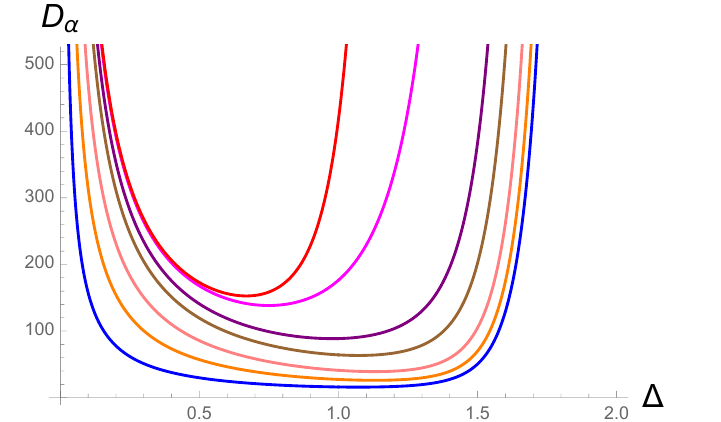
Figure 1 . Sample plot of the R(cid:19)enyi divergences. The di(cid:11)erent curves correspond to (cid:11)